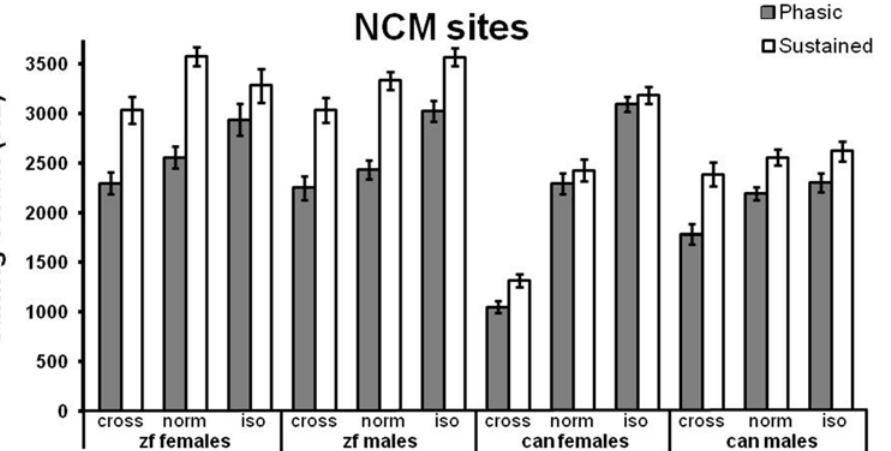
Figure 2. Tuning width in NCM for zebra finches and canaries of each sex, and in each housing condition (CROSS, NORM, and ISO). Tuning width is compared across phasic response windows (gray bars) and sustained response windows (white bars). Overall tuning is broader in ISO birds, and narrower in CROSS birds, relative to NORMs. Activity during the response interval that was more than 1 SD above control level was considered a response. The tuning width was estimated as the largest number of contiguous frequencies in the stimulus set that elicited such a response. That number was multiplied by the spacing of the stimuli in the set (250 Hz) to produce a measure of tuning width. As reported previously (Terleph et al., 2007), overall tuning is broader for zebra finches than canaries. However, species differences are more pronounced between the CROSS groups, and the tuning width of ISO canary females is comparable to that of zebra finches. Error bars represent 6 1 SEM of all recording sites in each region.